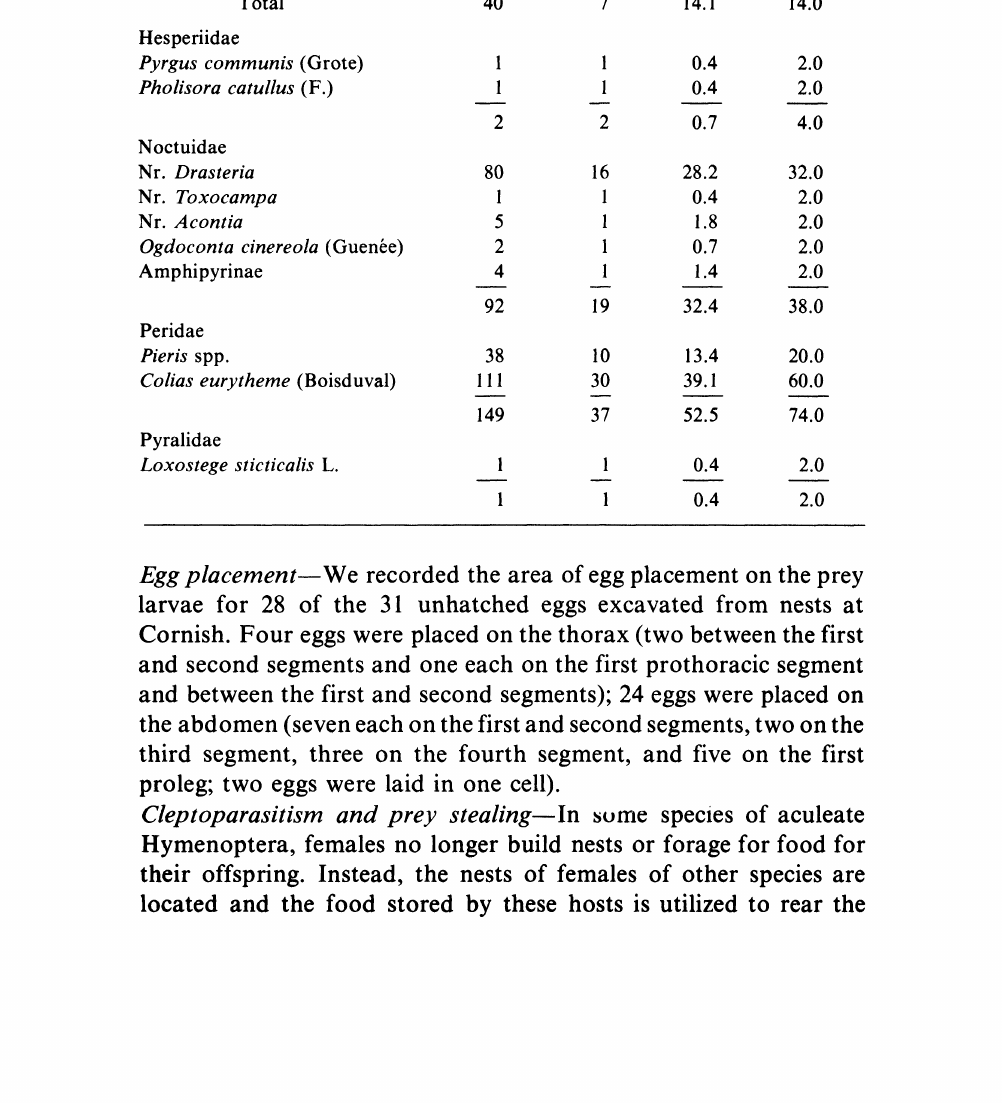
Table 1. Prey records from 50 Cornish nests. Total number of nests exceeds 50 because more than one taxa frequently occur in same nest. Total Percent Total Taxa Larvae Nests Larvae